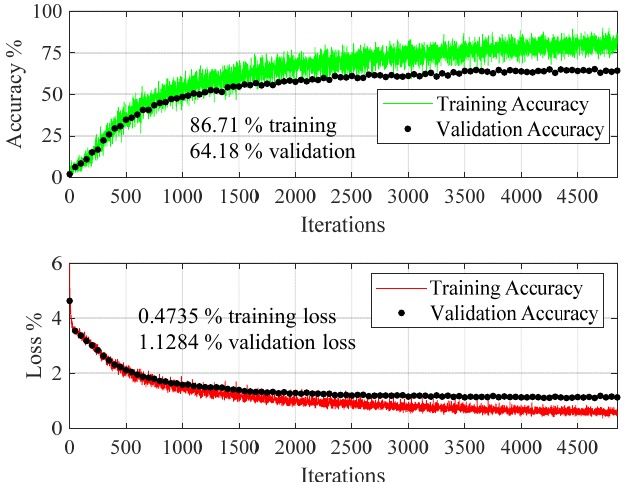
Figure 13. Training and validation performance of customized deep learning model original data. (Solid line shows training, dot refers to validation).